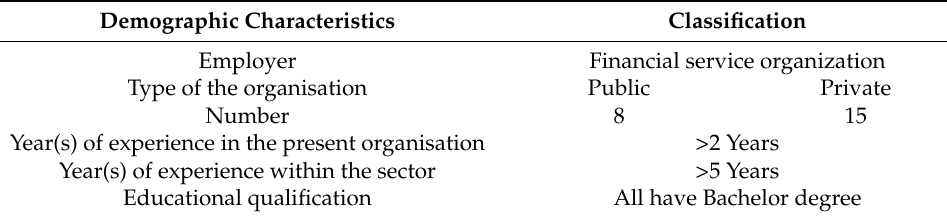
Table 1. Profiles of respondents.